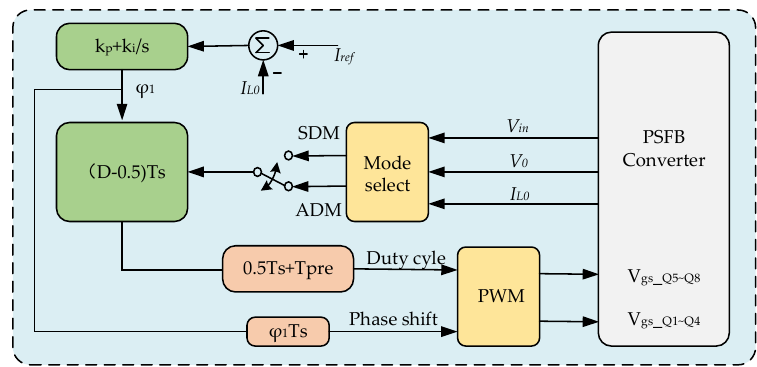
Figure 20. Simpli fi ed control chart of PSFB reverse operation. Figure 20. Simplified control chart of PSFB reverse operation.